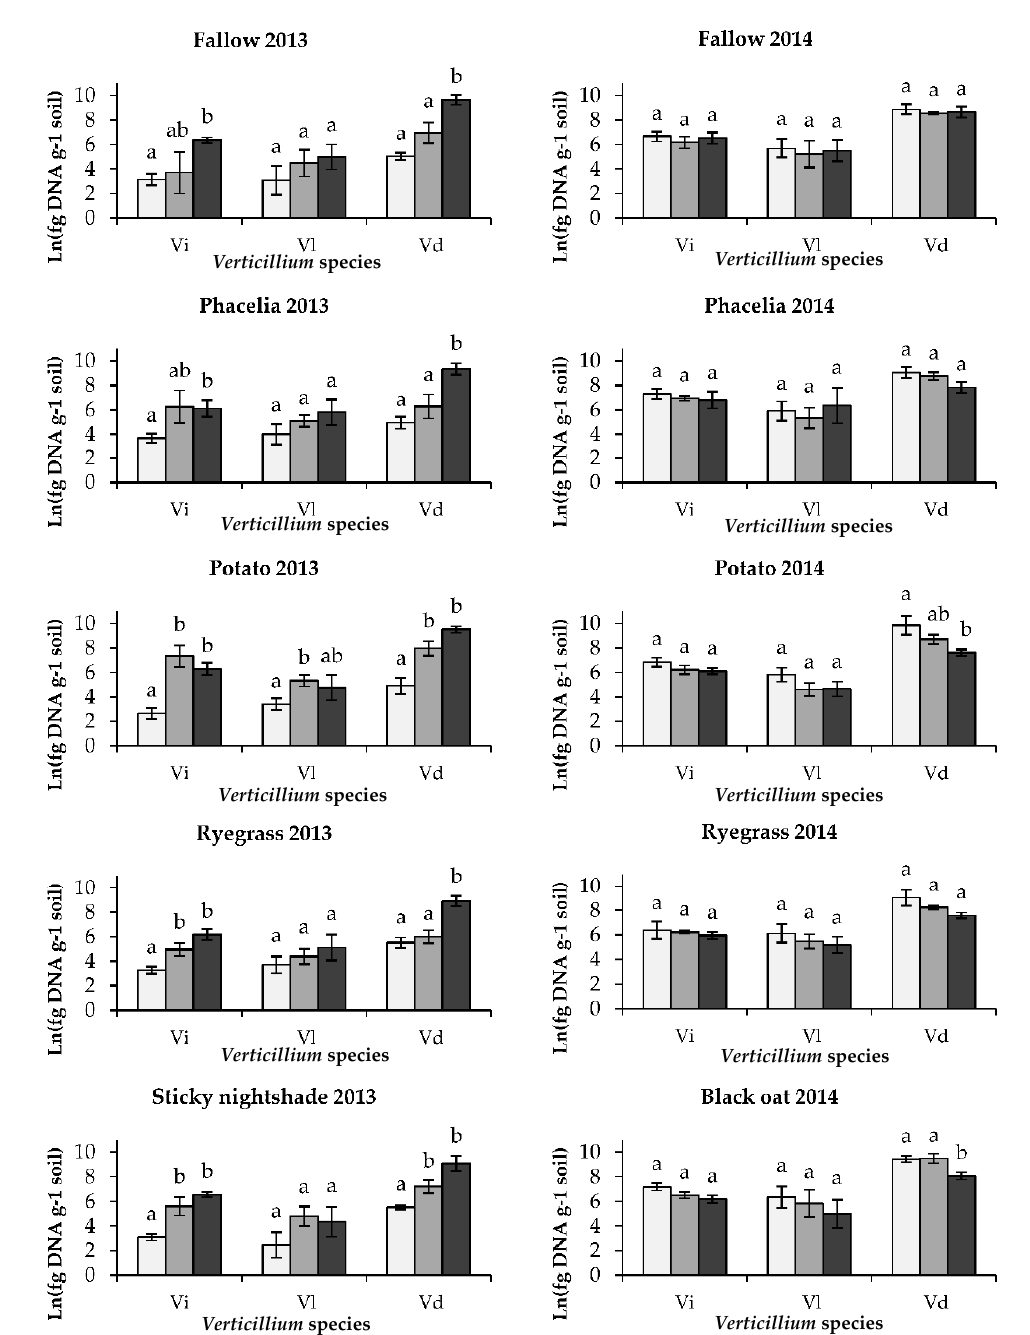
Figure A1. Inoculum densities of V. isaacii (Vi), V. longisporum (Vl) and V. dahliae (Vd) at three time points ( : sowing/planting of crop 1, : incorporation of crop 1 and : harvest of cauliflower) in a grower’s field located in Ardooie during the growing seasons of 2013 and 2014 in five cover crop systems. Values are the mean of 4 replicates and the vertical bars represent the standard error of the mean. Data were ln transformed before statistics. For each Verticillium species, bars with different letters indicate statistical differences according to Tukey tests ( p < 0.05).